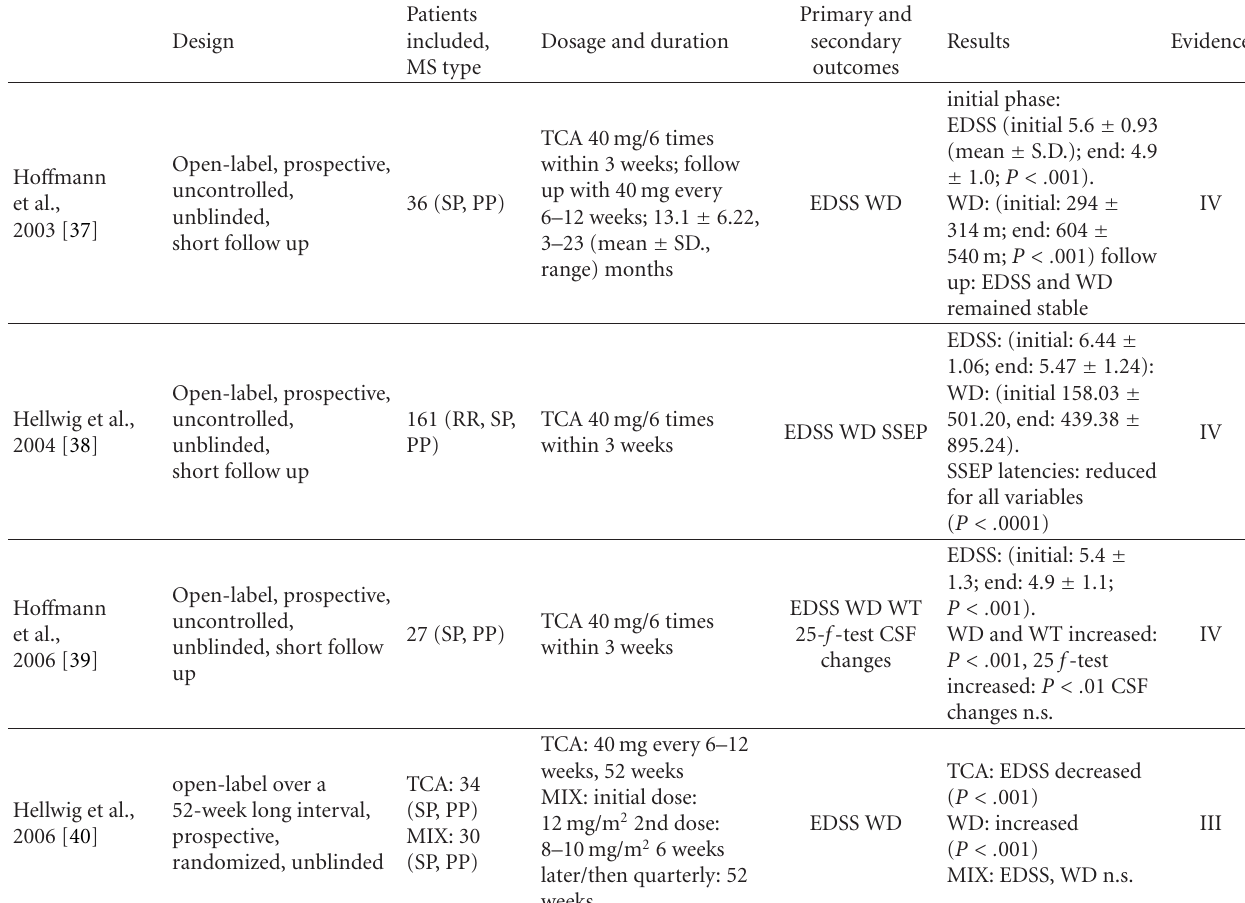
Table 2: Representative intrathecal steroid investigations in multiple sclerosis (since